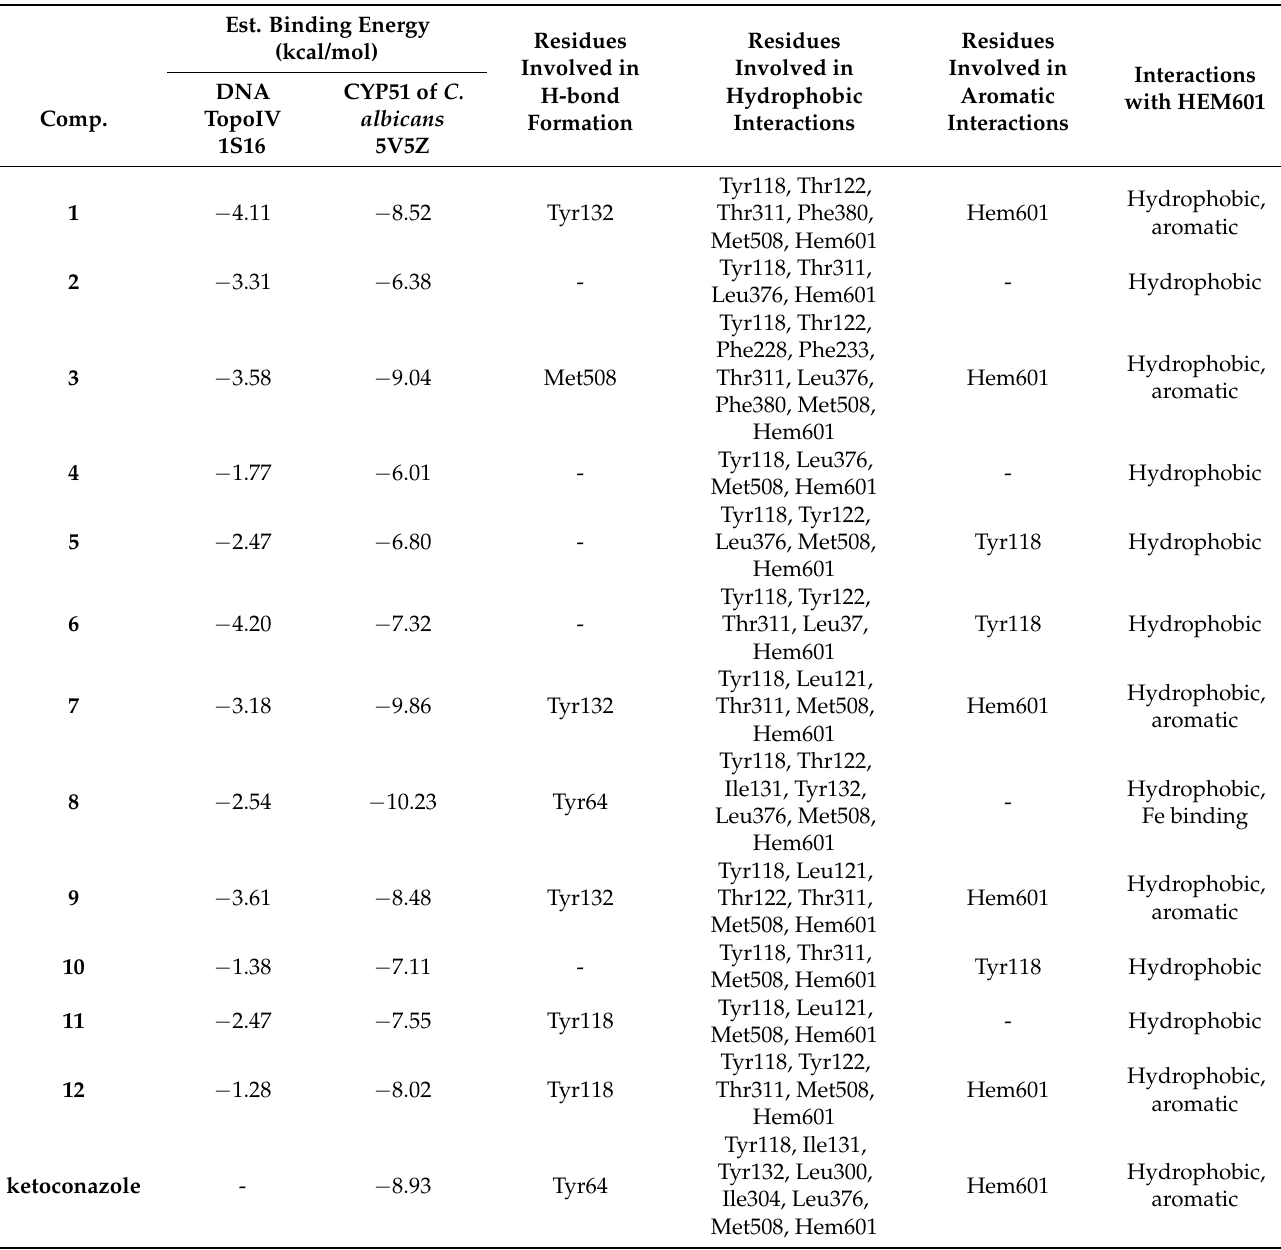
Table 3. Molecular docking free binding energies (kcal/mol) to antifungal